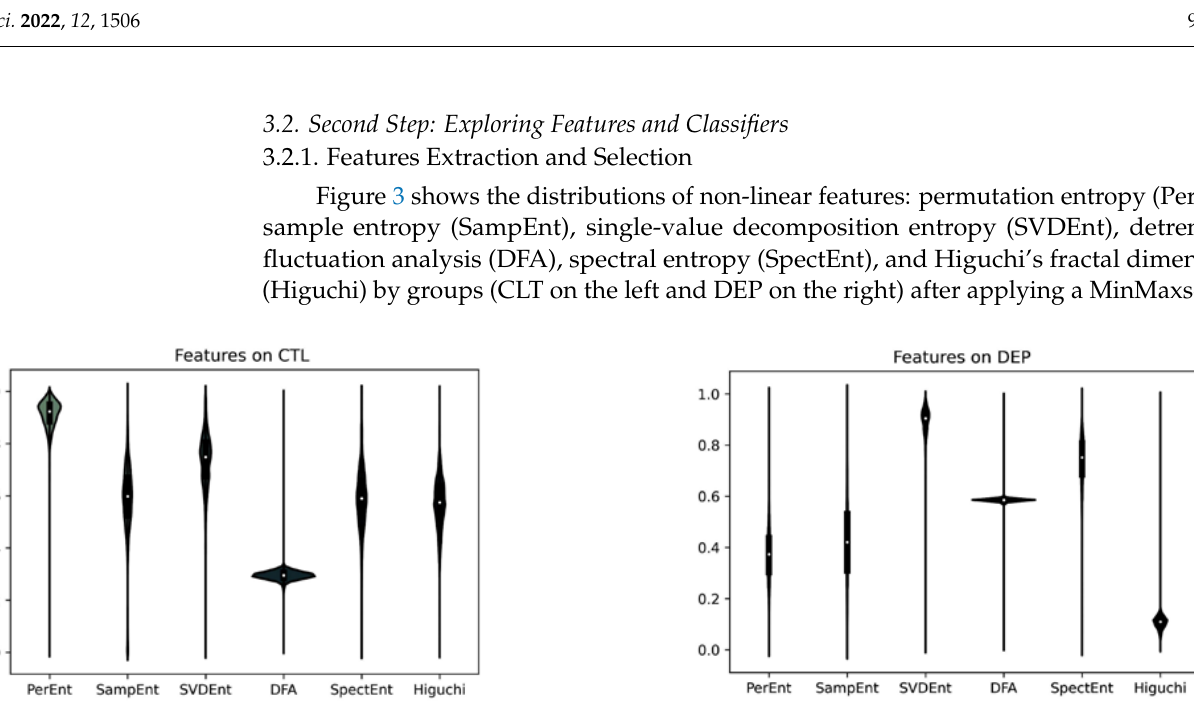
Figure 2. Accuracy comparison between brain areas associated with the electrodes at the lateral